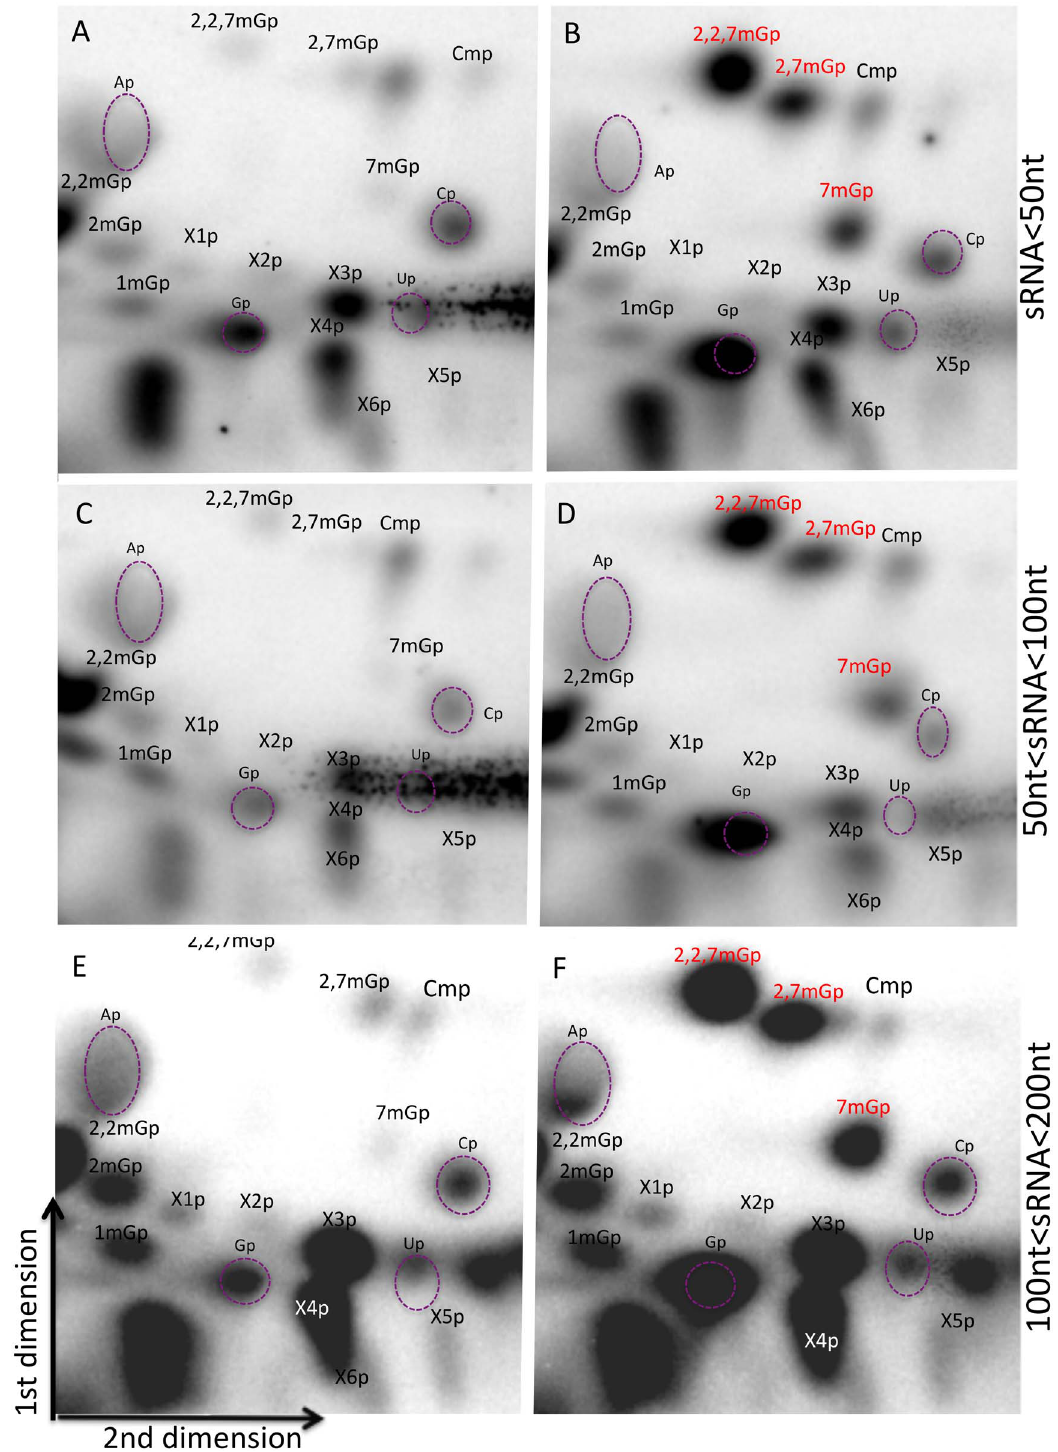
Figure 4. Thin layer chromatography reveals cap structures on sRNAs at all length ranges. A–F: 2D-TLC of radiolabelled cap structures. Long cleavage products corresponding to sRNAs remained immobile on the spotting origin (bottom left corners), and dinucleotides formed large spots at the lower right corner and mid left side, while the cap structures and mononucleotide degradation products migrated further up and right. The first dimension was run using solvent A (see materials and methods) and is displayed from bottom to the top. The second dimension was run using solvent B (left to right). Three size fractions were investigated: , 50 nt (A–B), 50–100 nt (C–D), and 100–200 nt (E–F). The position of cold mononucleotides Ap, Gp, Cp, Up detected by UV shadowing is indicated by purple dashed ellipses. B, D, F: chromatographies in presence of radiolabelled standards for Gp, 7 mGp, 2,7 mGp and 2,2,7 mGp. Spots were assigned according to the reference Kieth 1995 or referred to as X.